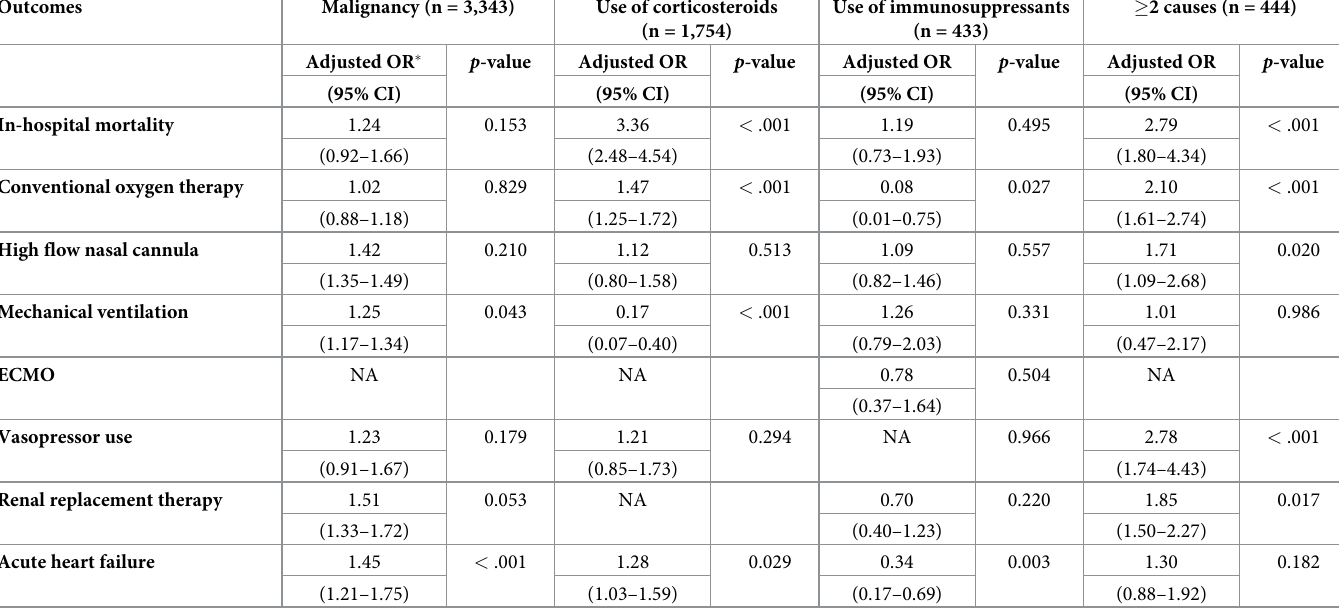
Table 4. Risks of outcomes in the subgroups of immunocompromised COVID-19 patients after